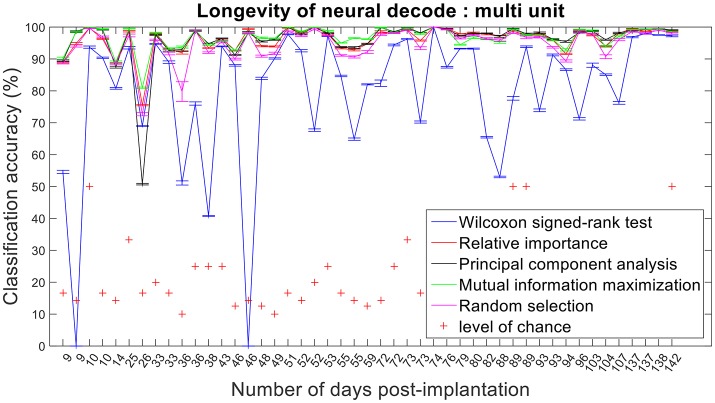
Longevity of neural decodes using multi-unit firing rate. High levels of accuracy over an extended period of time is imperative for a fully functional neuroprosthesis. On certain days, two sessions of recordings were conducted. Repeated x-axis indices (Number of days post-implantation) in the above figure correspond to different sessions conducted on the same day.